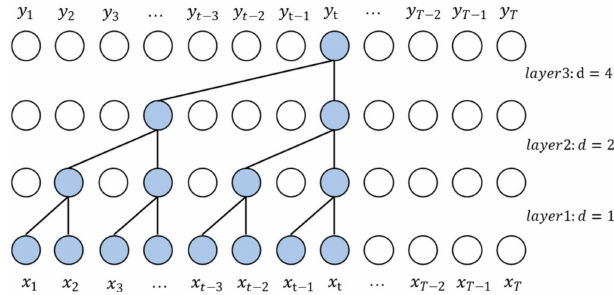
Figure 3. One-dimensional dilated causal